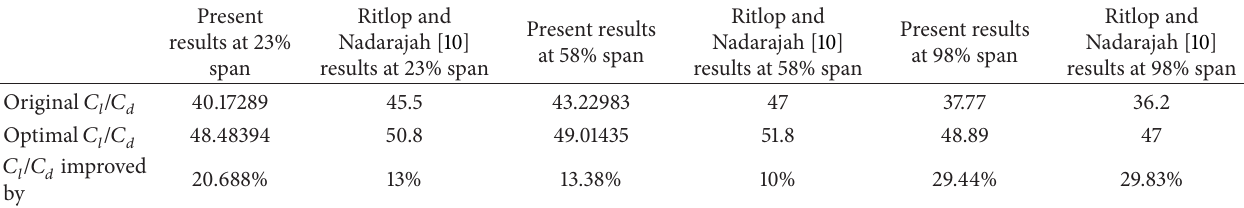
Table 6: Comparison of 𝐶 𝑙 / 𝐶 𝑑 of optimized airfoils: present results and those of Ritlop and Nadarajah